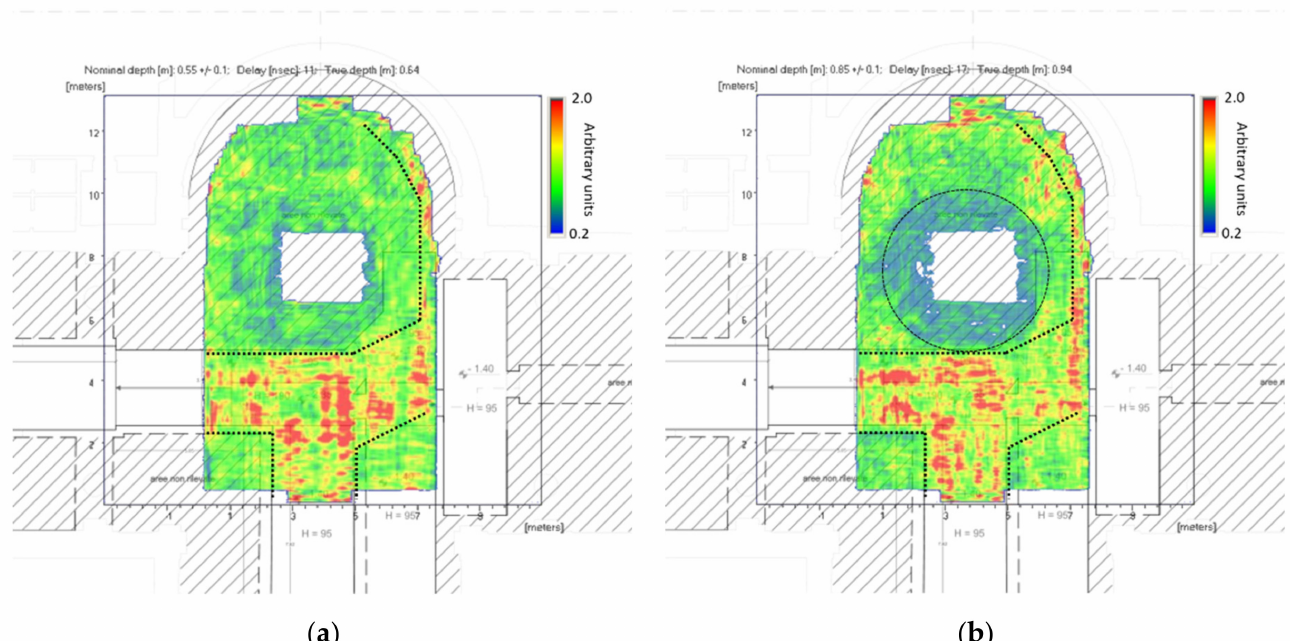
Figure 13. C-scan: ( a ) 0.74 m depth; ( b ) 1.40 m depth. The circle spotlights the interface between the soil and the possible basement.